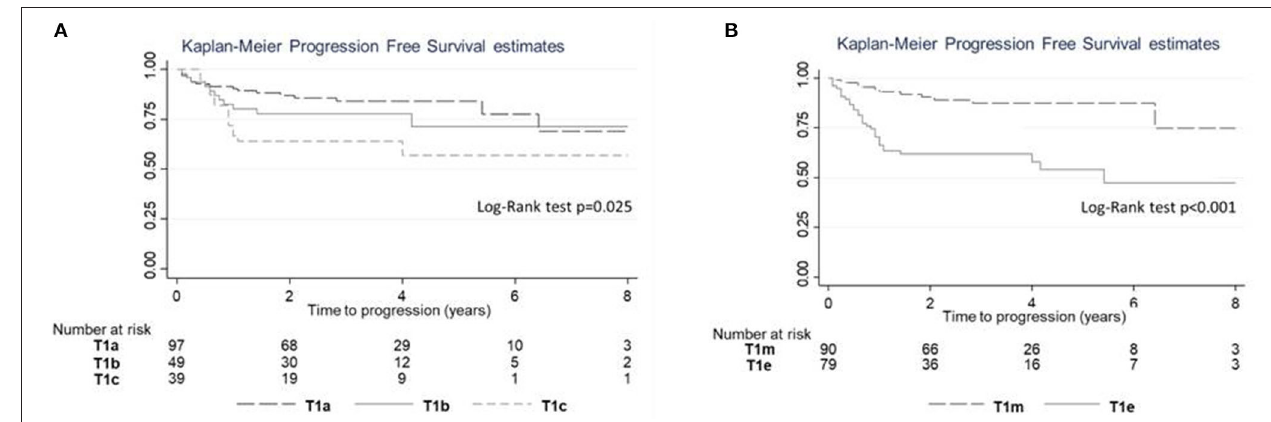
FIGURE 6 | Progression-free survival (PFS) estimates according to subcategory. (A) PFS for subcategories T1a–c. (B) PFS for subcategories T1m–e.